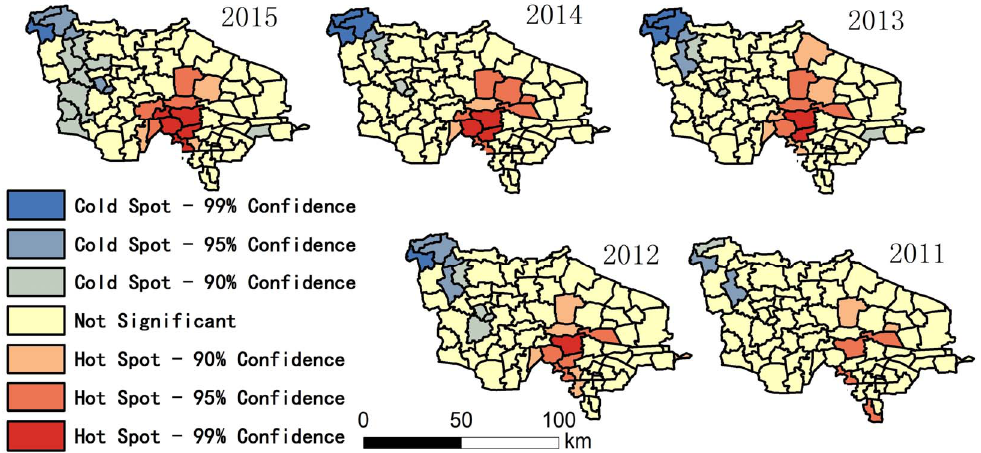
Figure 14. Hot spot in relation to the proportion of people aged 90–99 in comparison with those aged